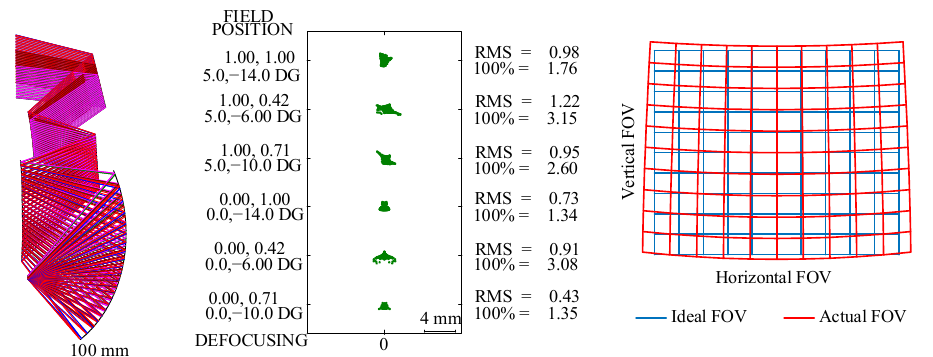
Figure 6. System M 2 obtained using the focal length reduction method. System M 2 was then optimized. The optical path diagram, the root mean square (RMS) wavefront error and the distortion grid of the system after the optimization process are shown in Figure 7. The maximum value of the RMS wavefront error was 0.0821 λ (where λ = 10 µ m) and the maximum absolute distortion was 4.7%.